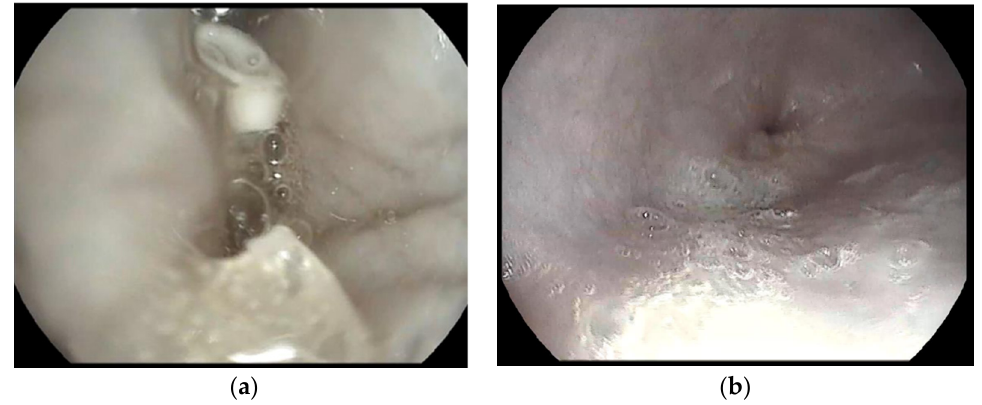
Figure 12. A gastroscopy scan 2 h after administration proved the gastroretention of the foamed capsule. The white body of the residue of the formulation can be seen on the upper part of the image ( a ). The capsule was eliminated from the empty stomach 4 h after administration ( b ).